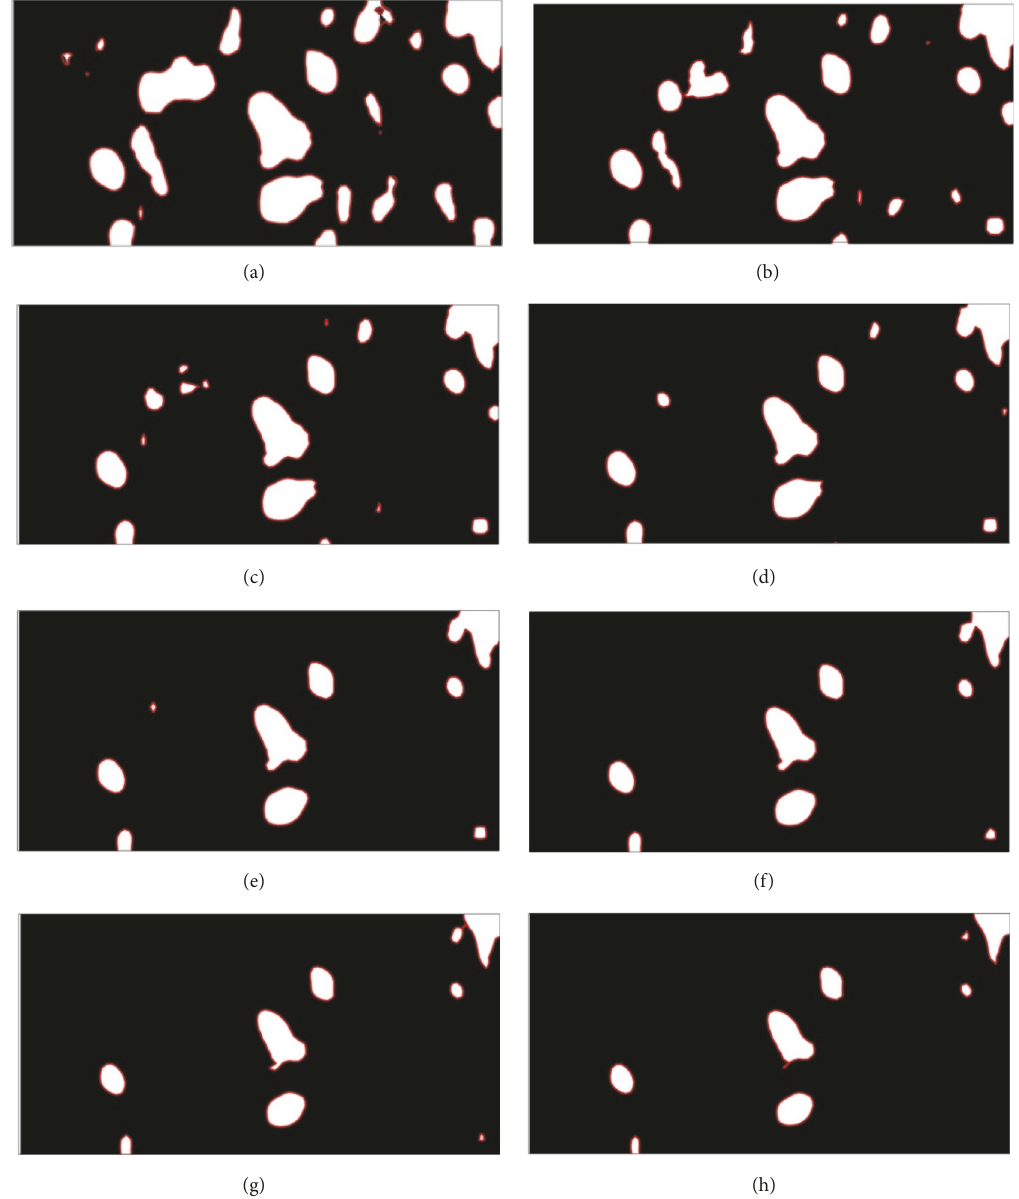
Figure 5: Black and white version of images in Figure 3 adapted to the Succolarity analysis